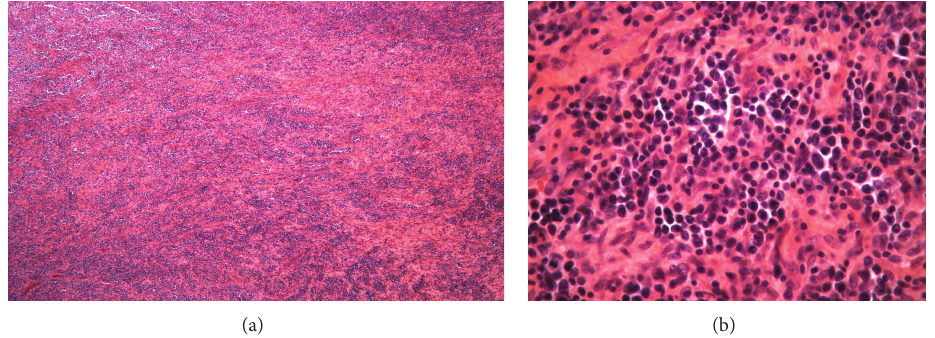
Figure 1: (a) Atypical lymphoid infiltrates associated with marked fibrosis (20x magnification) and (b) atypical cells with irregular nuclear membrane, open chromatin, and distinct nucleoli (200x magnification).